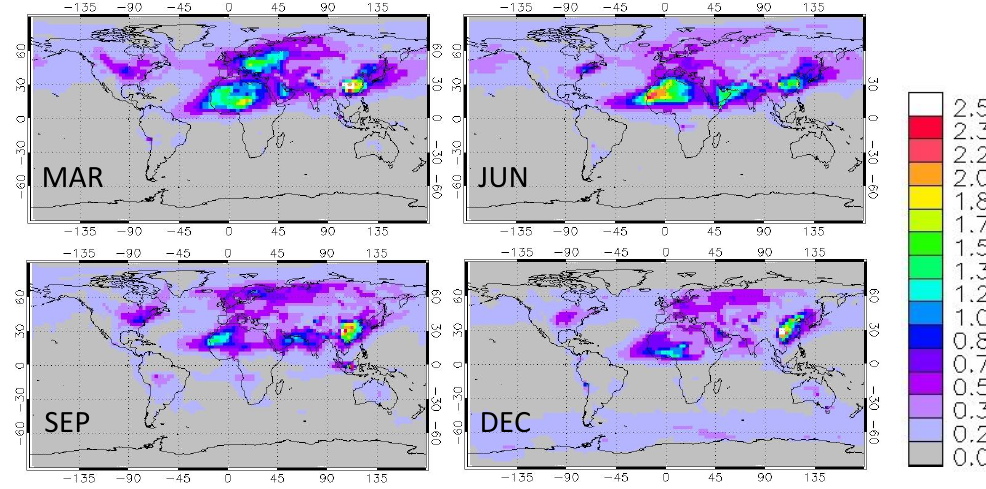
Fig. 8. Global distributions of monthly average total aerosol optical depth (AOD) for the base-case MOZART-4 simulations. 4